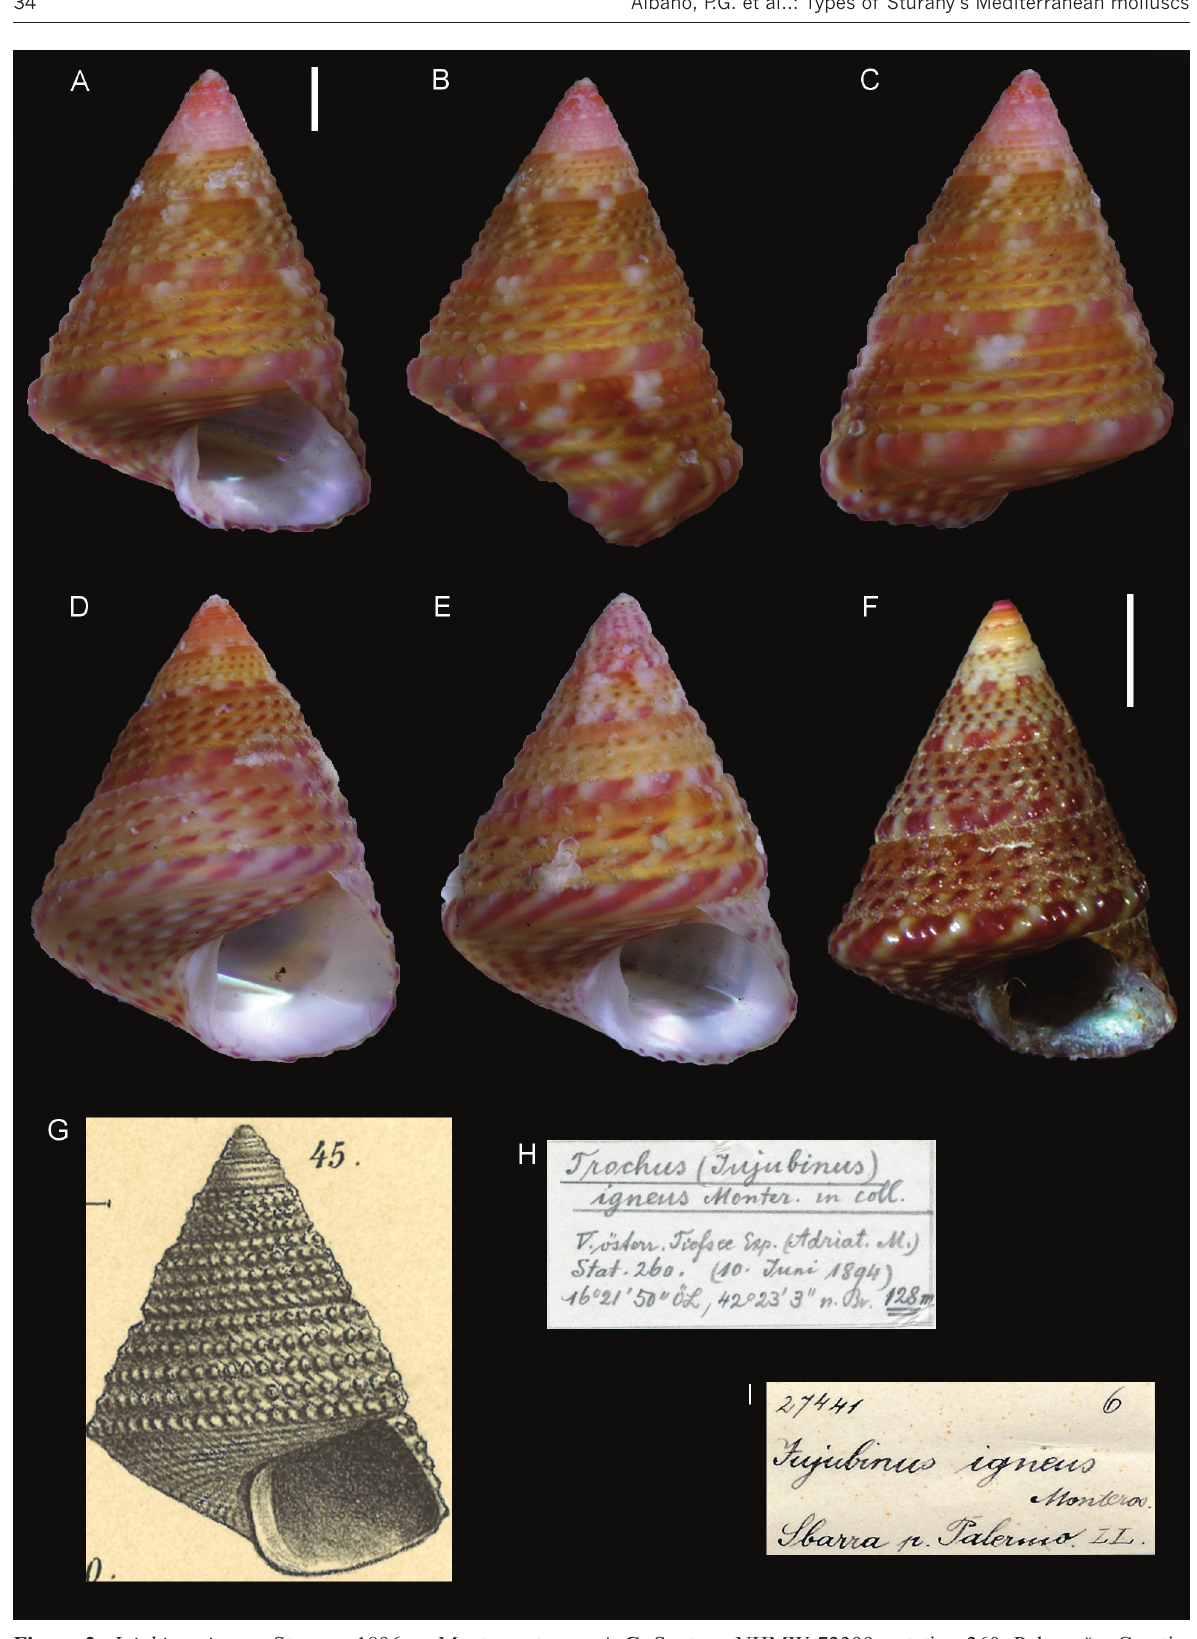
Figure 2. Jujubinus igneus Sturany, 1896 ex Monterosato ms. A-C . Syntype NHMW 72399a, station 260, Pelagru ž a, Croatia, 128 m: front (A), side (B) and back (C) views. D–E . Syntype NHMW 72399b and c: front views. F . NHMW 27441 (Monterosato coll.): front view. G . Original figure in Sturany, 1896. H . Original label of lot NHMW 72399. I . Original label of lot 27441. Scale bar: 1